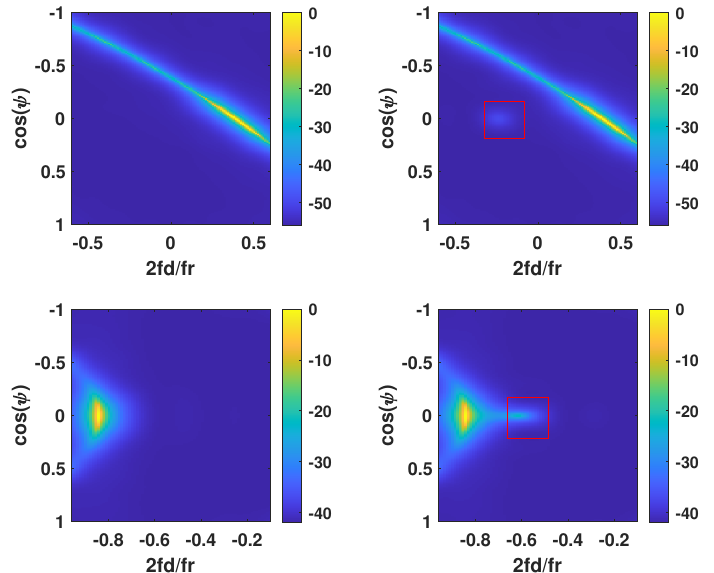
Figure 5. Space-time spectrum distributions of clutter without a target ( left column) and with the target ( right